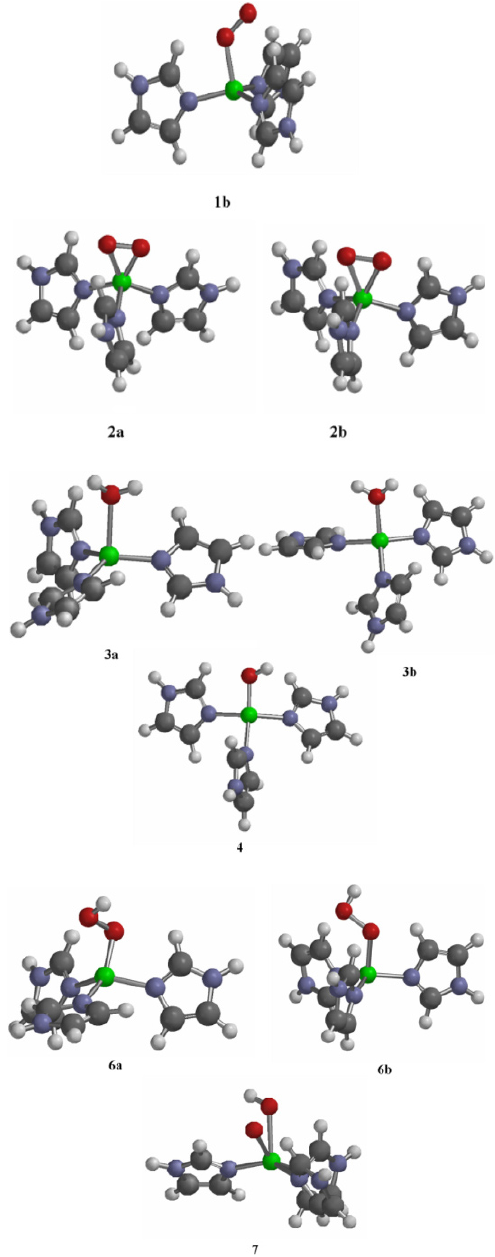
Figure 3. Optimized geometries of the studied